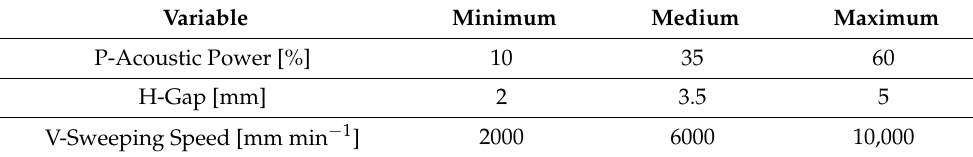
Figure 6. Factorial design of experiments with 9 points. P is the ultrasonic power; H is the gap and V the sweeping speed. Table 2. Limit values for each factor.